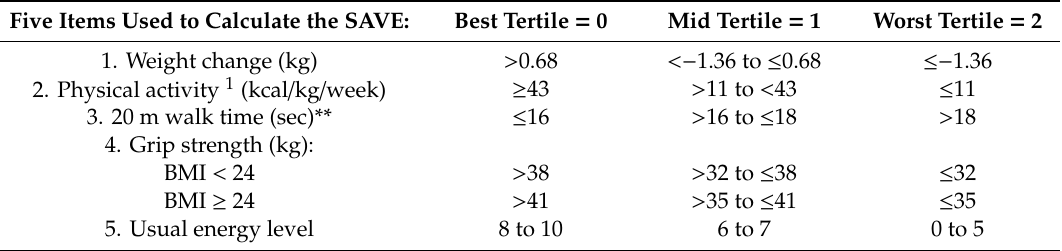
Table 4. Tertile cut-o ff s of the five items used to calculate the Scale of Aging Vigor in Epidemiology (SAVE) for 287 black men from the Health, Aging, and Body Composition (Health ABC) study based on information from all Health ABC